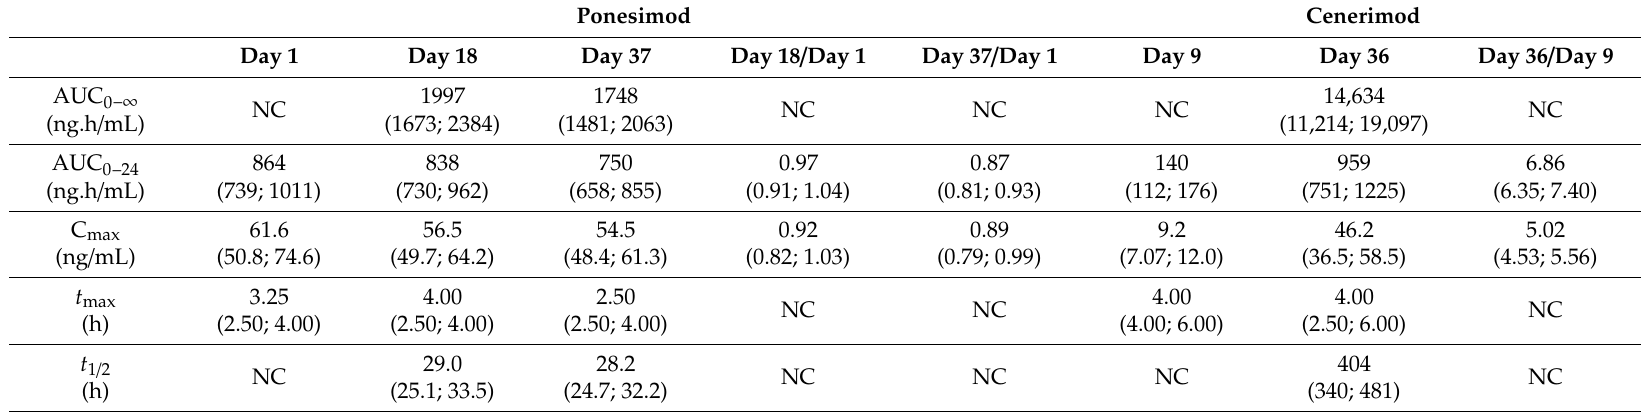
Table 1. Pharmacokinetic parameters of ponesimod and